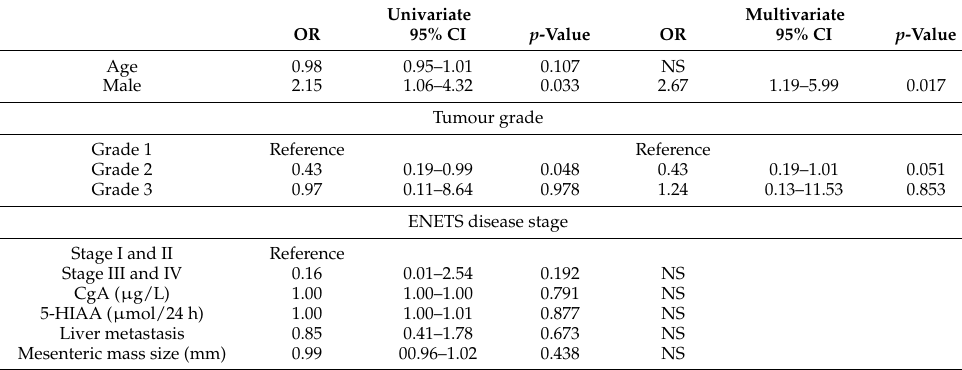
Table 3. Predictors of growth in patients with mesenteric mass ( N = 329). Univariate Multivariate OR 95%